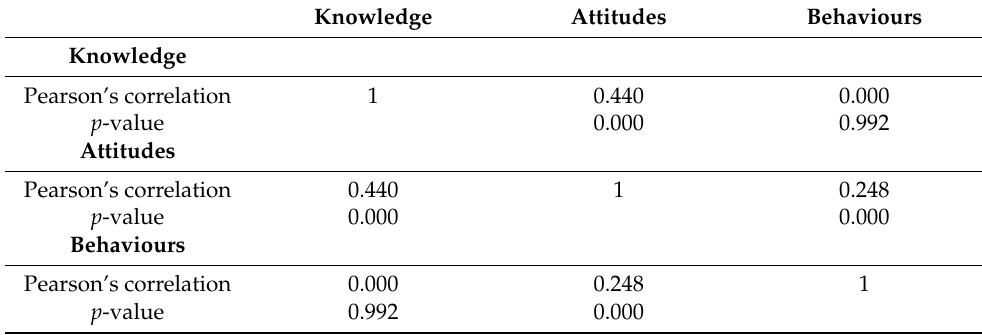
Table 6. Pearson’s correlation between knowledge, attitudes, and behaviours. Knowledge Attitudes